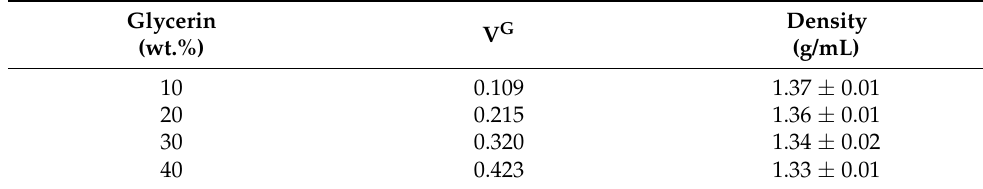
Table 3. Glycerin conditions, the volume fraction of glycerin (V G ), and density of the resulting thermoplastic lignin.